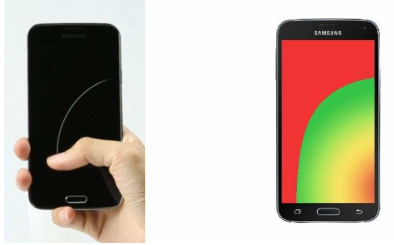
Figure 1. Limited touching range of the thumb on the Samsung Galaxy S5.